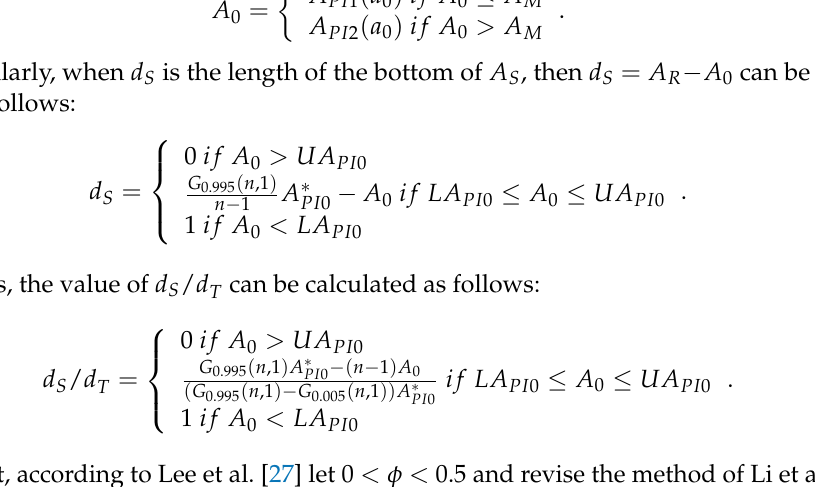
Figure 2. The membership function ( ) x η with vertical line